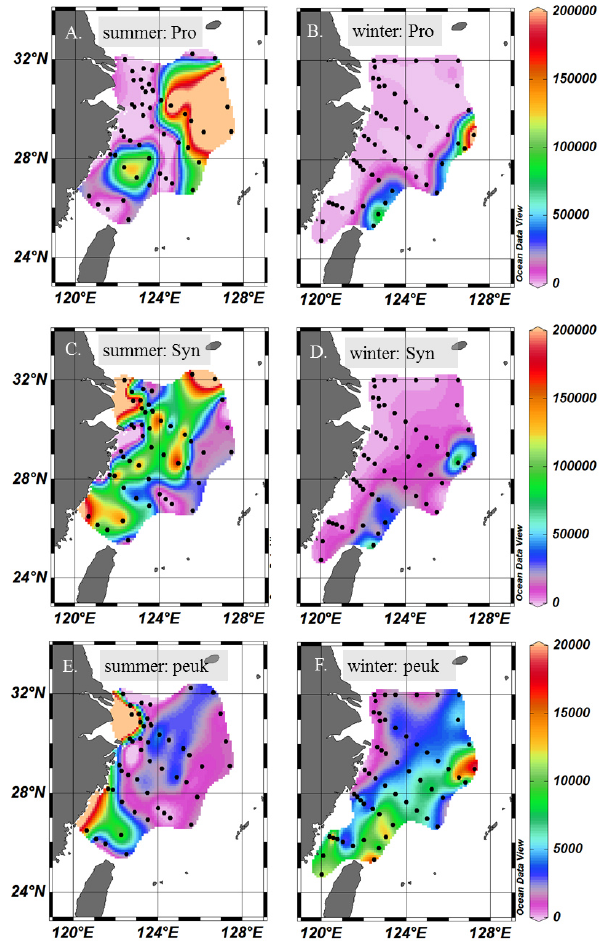
Fig. 4. Spatial distributions of surface abundances (cellsmL − 1 ) of